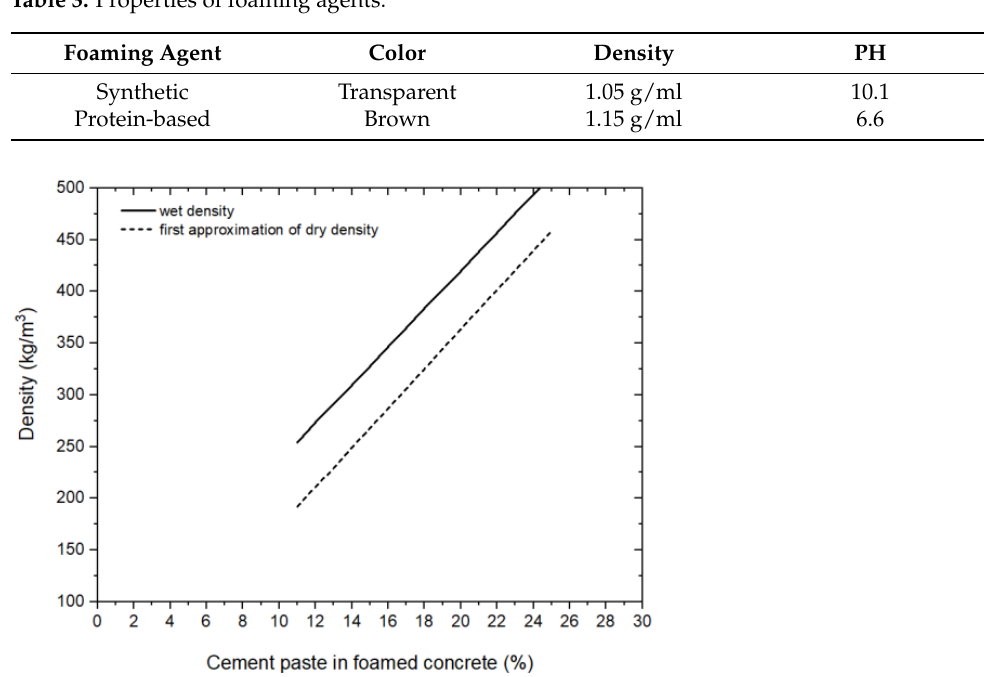
Table 3. Properties of foaming agents.